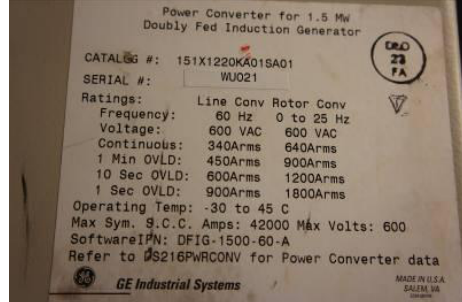
Figure 1. Nameplate of power converter used in the wind